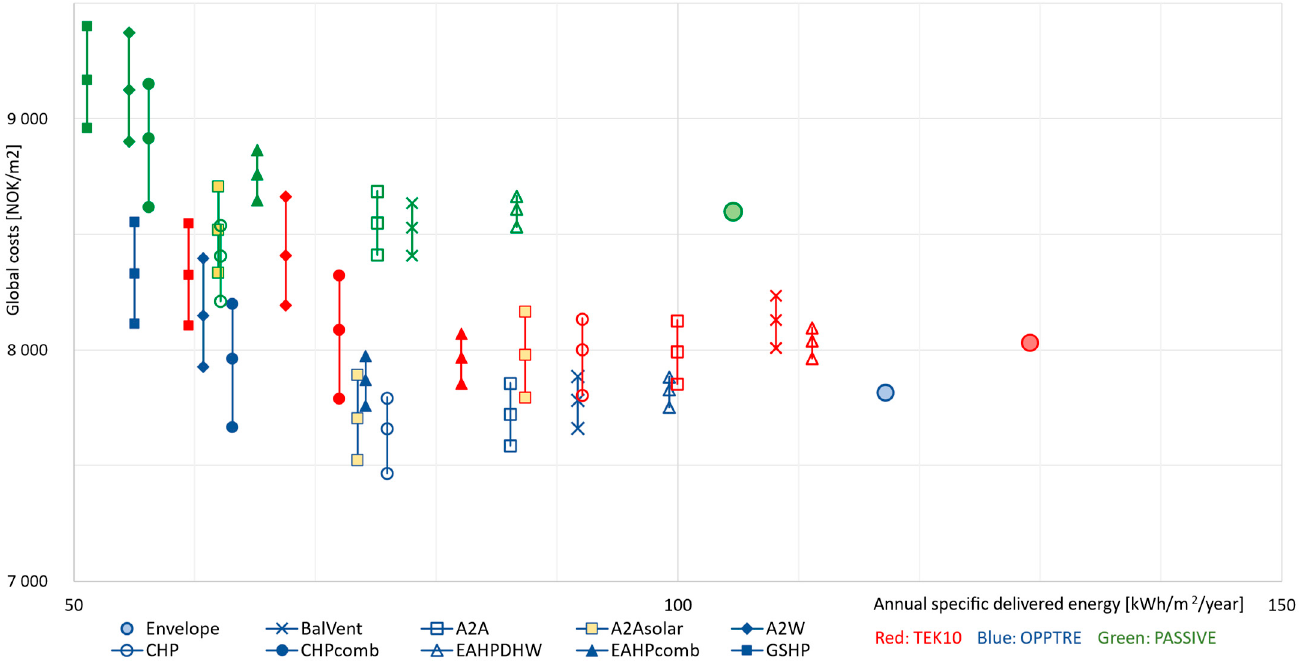
Figure 10. Specific global costs and delivered energy of the Kristiansand house with electricity price 2.0 NOK/kWh. 2.0